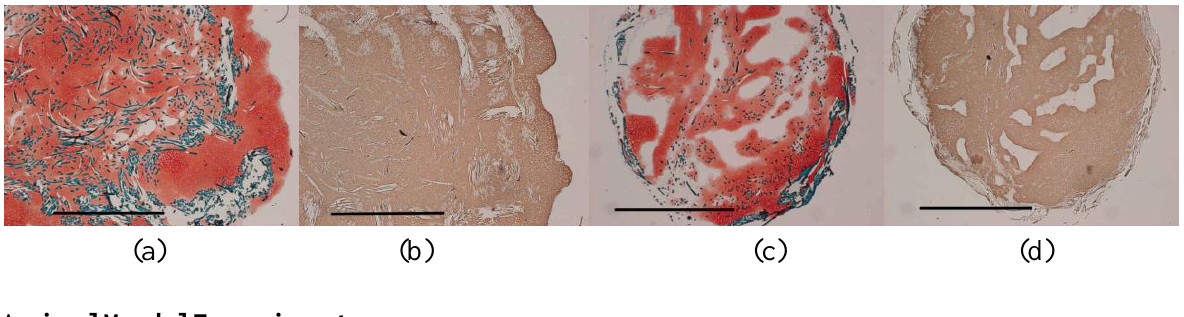
Figure 7. Histological and immunohistochemical appearance of engineered cartilage in the cushion-type ( a , b ) and in the cylinder-type ( c , d ) scaffold at eight weeks after cultivation. Safranin-O staining shows the formation of a proteoglycan-rich cartilaginous matrix (a, c). Immunohistochemical staining with antitype II collagen demonstrates the rich production of type II collagen in engineered cartilage (b, d). Scale bars indicate 5 mm